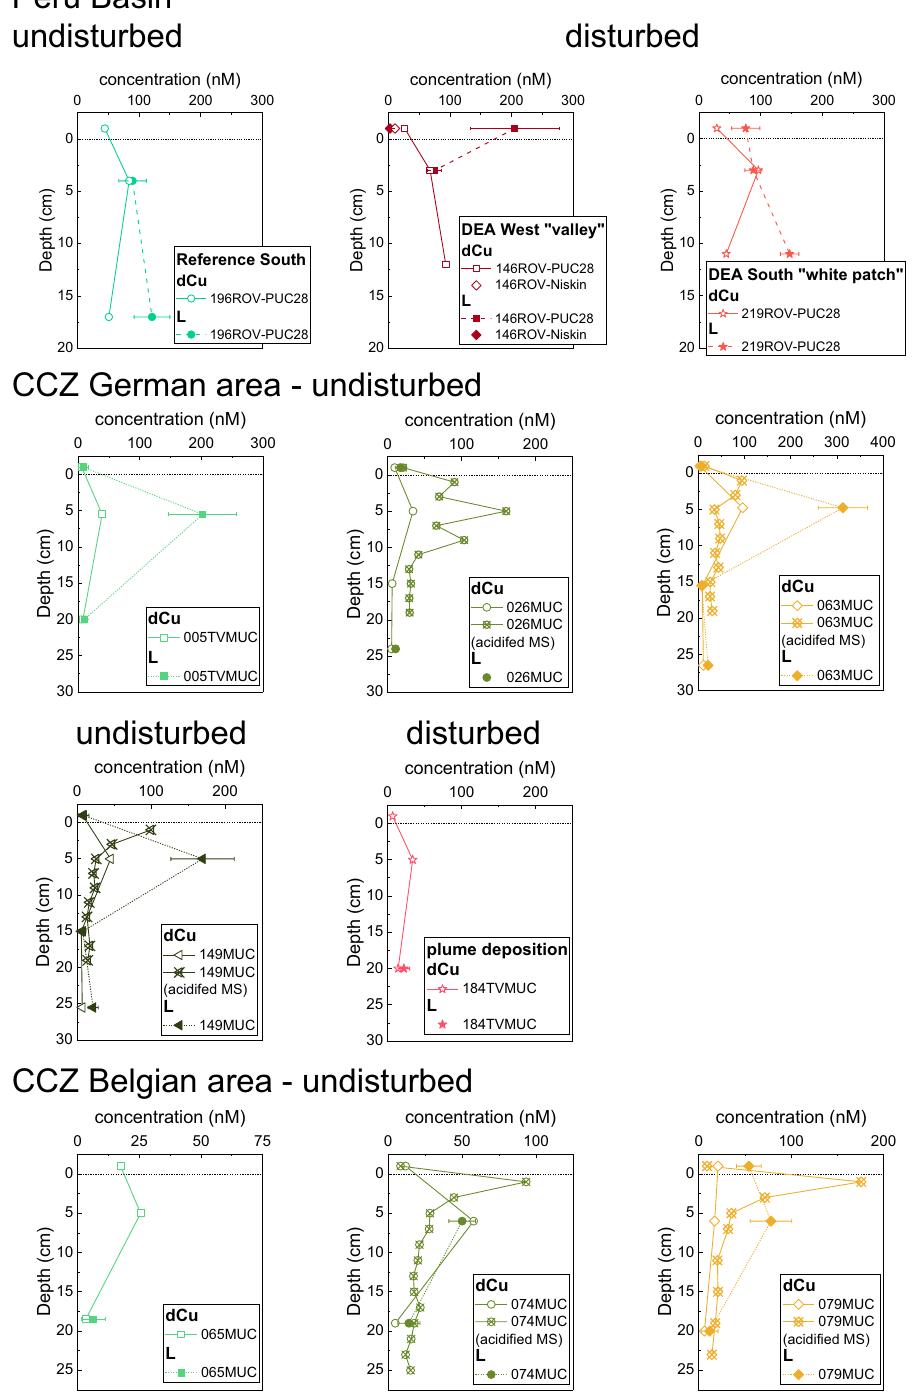
Figure 2. [dCu] and [L] plotted vs. depth for each core from the Peru Basin and CCZ—German and Belgian license areas (pooled samples, for details see Table 1). The uppermost value (− 1 cm) shows the bottom water. For some cores, [dCu] data from a second core sampled at higher resolution, acidified with HCl and measured by ICP-MS is shown. Because of pooling of the low-resolution dCu data for the ligand samples, the high- and low-resolution dCu profiles sometimes deviate with high-resolution data usually showing higher [dCu] in the upper few cm. For the pooled samples, the average depth is shown. Note different concentration axes scales. Bottom water for 065MUC was sampled from an adjacent liner and not from the same liner from which pore water was